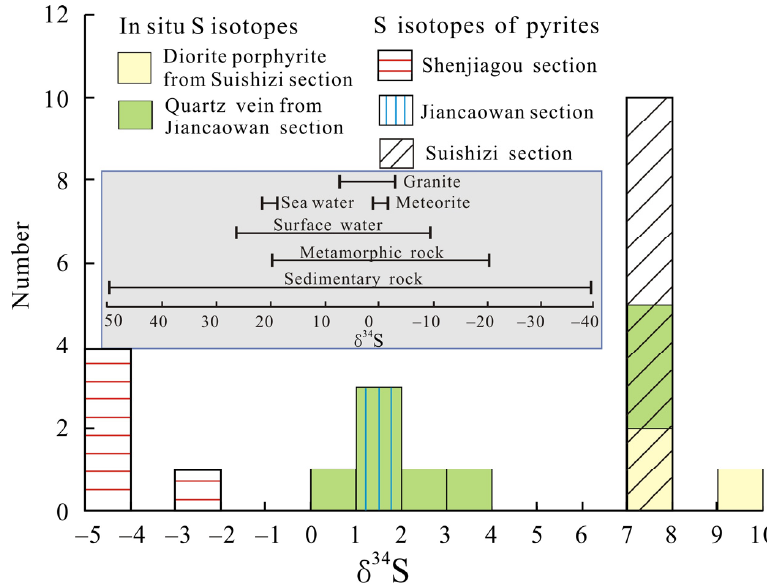
Figure 11. δ 34 S values of hydrothermal fluids in the Liziyuan Au deposit.